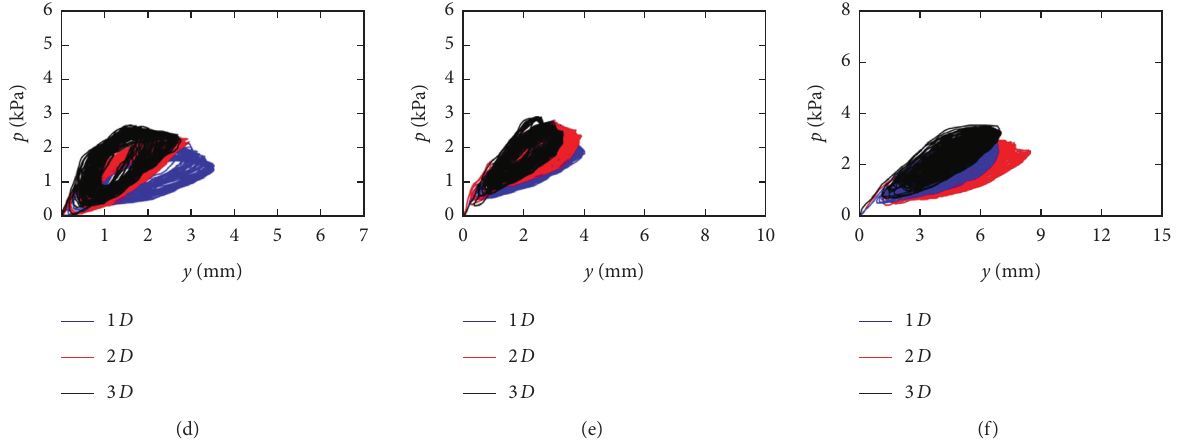
Figure 13: Cycle p - y curve: (a) case 1; (b) case 2; (c) case 3; (d) case 4; (e) case 5; (f) case 6.